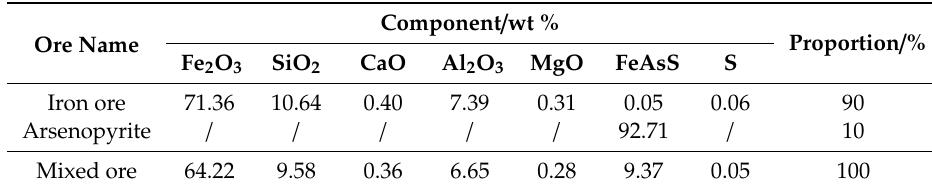
Table 1. Composition and proportion of roasting